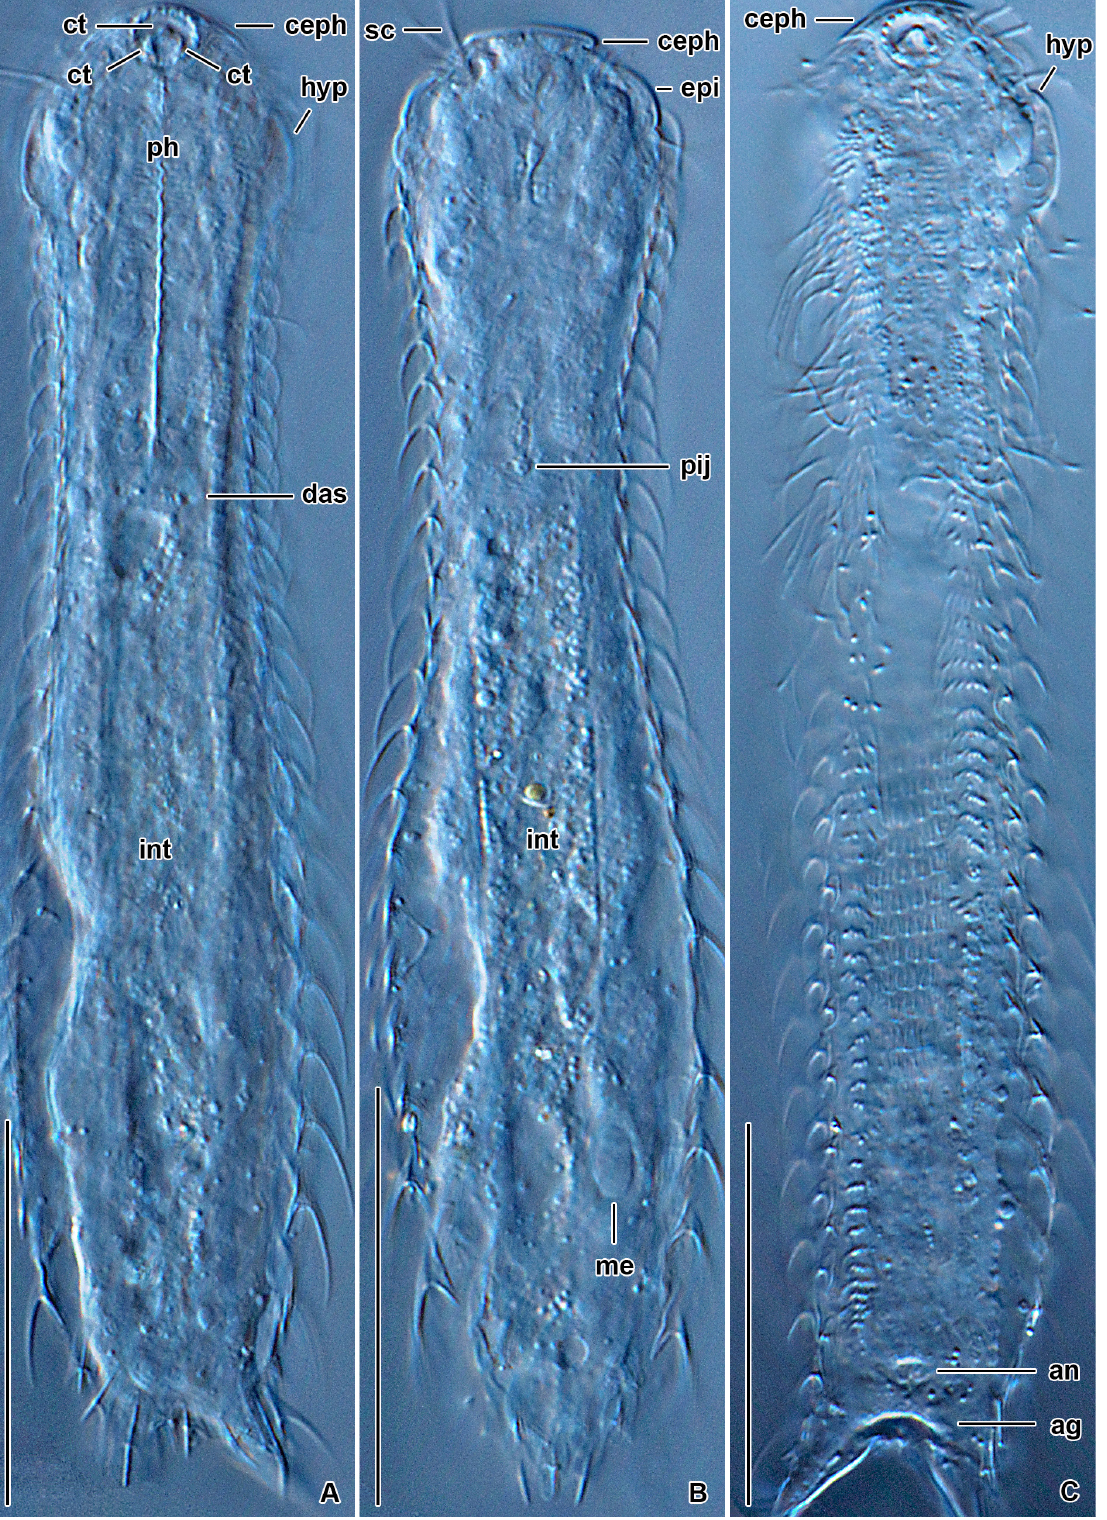
Fig. 25. Chaetonotus ( Hystricochaetonotus ) avarus sp. nov., paratype (CU-FNS-26-02-20/PA-2), differential interference contrast. A – B . Optical section showing the internal morphology. C . Ventral overview. Scale bars = 30